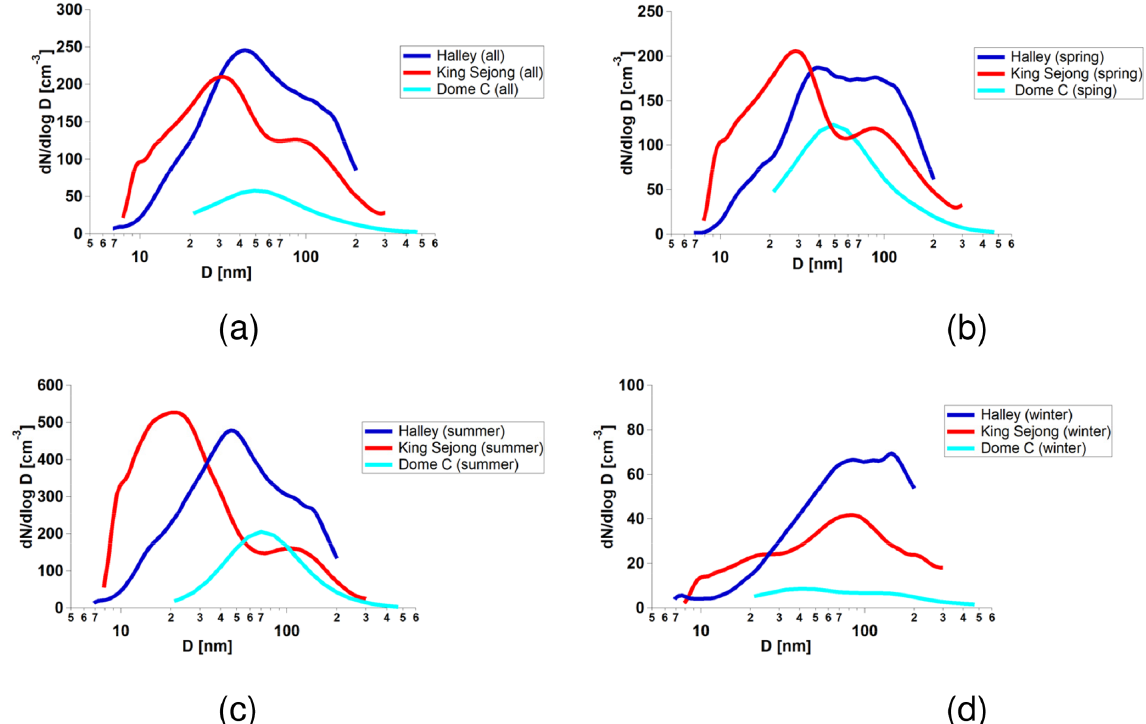
Figure 6. Average size-resolved particle size distributions simultaneously measured during the year 2015 at Halley, Dome C and King Sejong stations for (a) May–December (8 months), (b) spring (September, October and November; 3 months), (c) summer (December; 1 month) and (d) winter (June, July and August; 3 months). D: diameter.